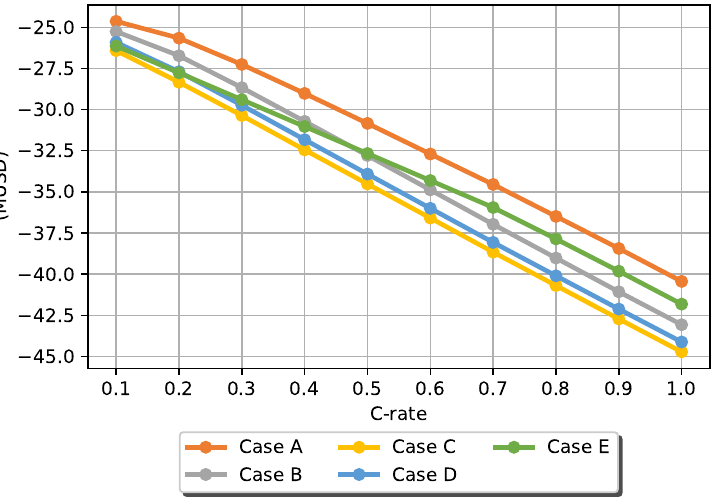
Figure 12. Net present value for each case